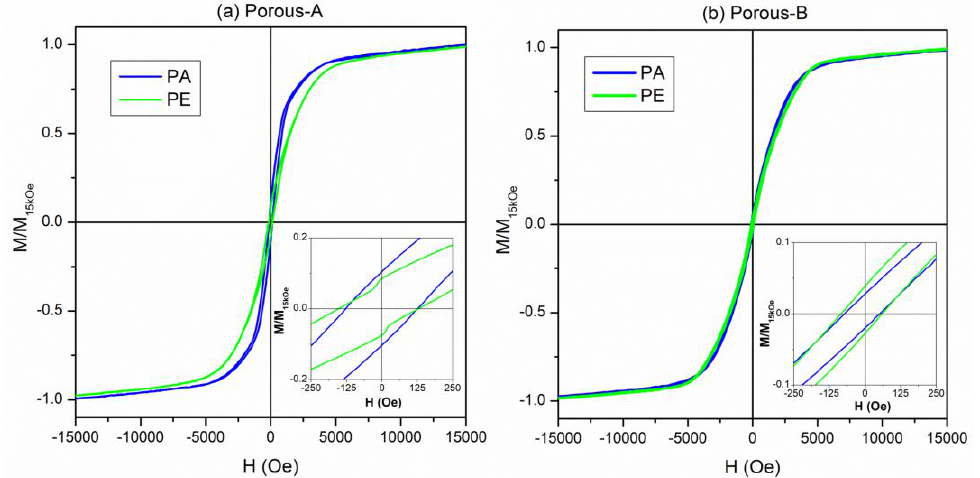
Figure 9. Room-temperature hysteresis loops of ( a ) Porous-A sample and ( b ) Porous-B sample by applying H along the direction parallel (PA) and perpendicular (PE) to the major axis of the NWs. Inset: enlargement of hysteresis loops at a low magnetic field.